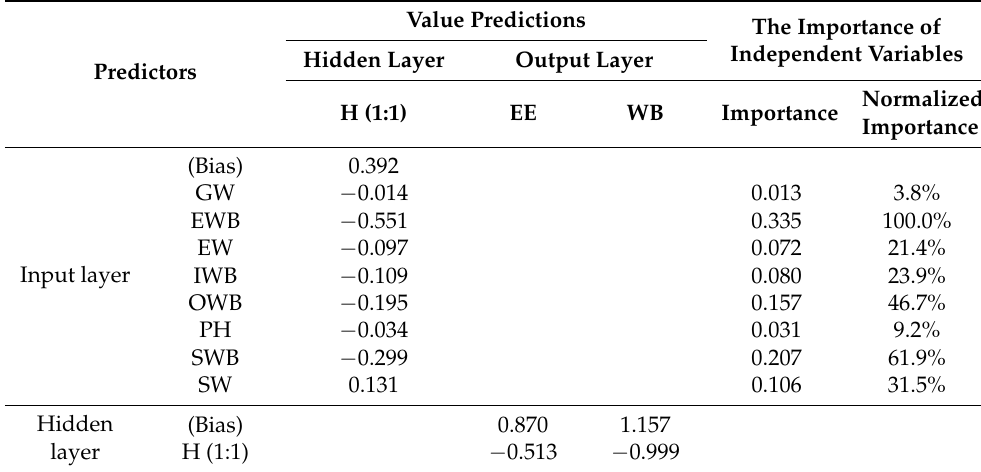
Independent VariablesHidden Layer Output Layer Normalized Importance 0.013 3.8% 0.335 100.0%